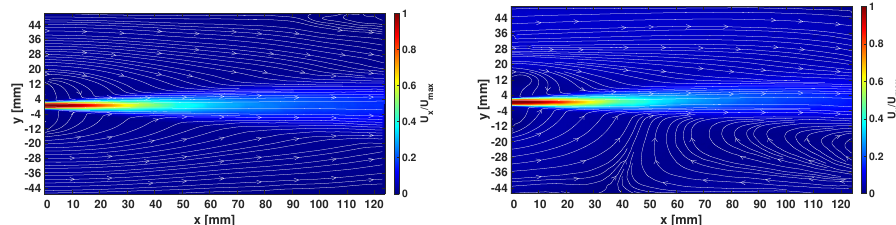
Figure 6. Mean flow field in the vertical symmetry plane with a single burner jet included in the model (for geometry, see Figure 3g), with M sec = 1 to the left and M sec = 5 to the right. The contours show the burner jet axial velocity and the streamlines show the entrainment of the secondary flow into the jet. Figure adapted from